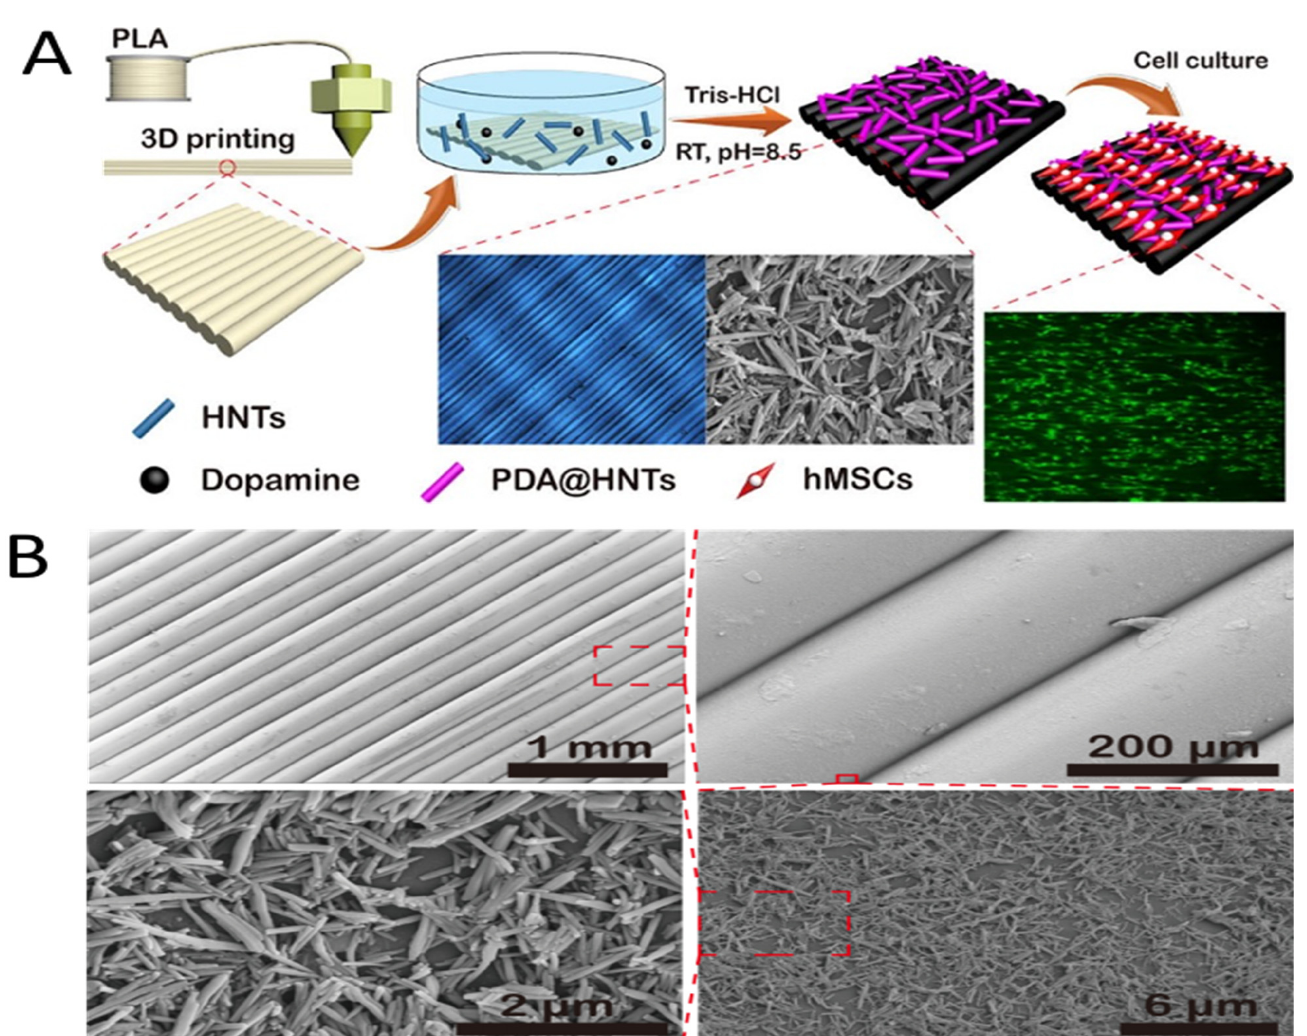
Figure 5. ( A ) Graphic abstract of the HNTs coated PLA printed scaffolds with different pattern for HNT patterns guiding cell orientation. ( B ) FE-SEM images of HNTs coated printed pattern surfaces with various magnification. Reprinted by permission of the publisher.